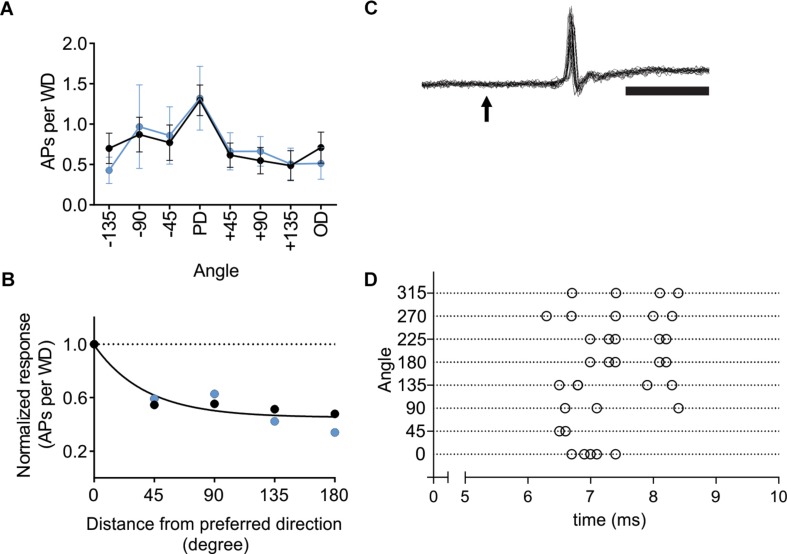
In VPM thalamus L6-Ntsr1 activation did not change direction selectivity. (A) Averaged whisker-evoked response (WER) for VPM cells (n = 8, two animals) in Ntsr1-cre animals in control (black line) and with L6-Ntsr1 photoactivation (blue line) measured for eight different directions. No significant difference between control and L6-Ntsr1 activation condition for any of the tested angles [Interaction: F(7,102) = 0.1586, p = 0.9924, two-way ANOVA]. (B) The WER normalized to the response for the PD. The WER showed the same dependence on whisker deflection angle in control and with L6-Ntsr1 activation (one curve fits for both data, extra-sum-of-squares F test, p = 0.4924). Direction selectivity index (DSI) was 1.42 for both conditions. (C) An example of a juxtacellular VPM recording. The arrow indicates the time point of whisker deflection. In this example, the whisker was deflected five times in four different directions, thus 20 sweeps are overlaid. Notably, there is no jitter in the latency of the first spike and response probability was 100%. Scale bar 5 ms. (D) Raster plot showing an example of the first spike latency for the eight different whisker deflection angles. Each angle was tested five times. The VPM cell in (D) is a different from that in (C).